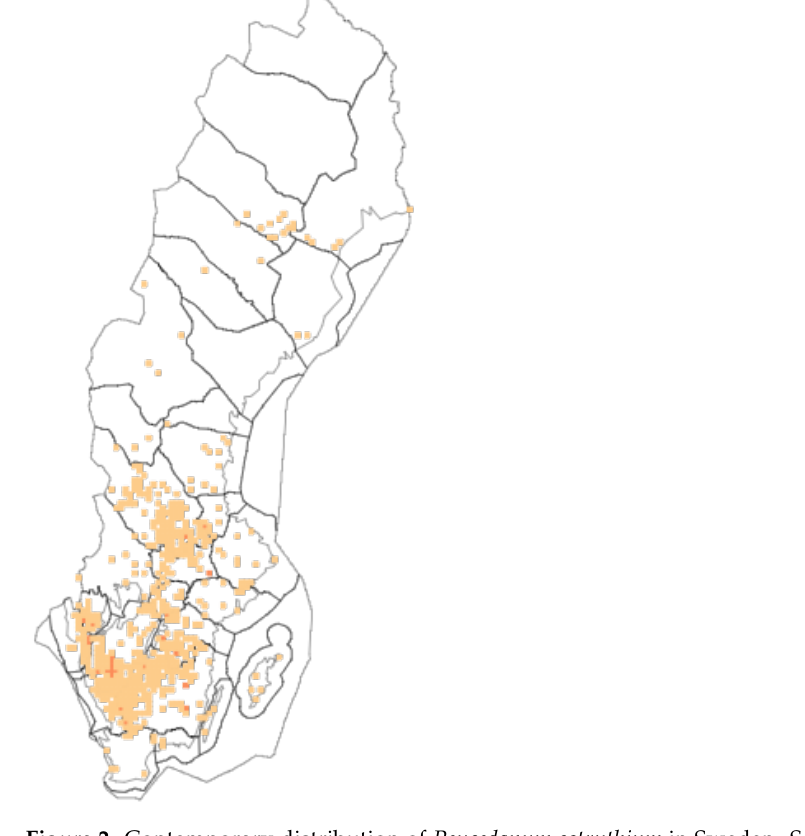
Figure 2. Contemporary distribution of Peucedanum ostruthium in Sweden. Source: SLU Swedish Species Information Centre. Light squares < 10 observations, dark squares 10–500